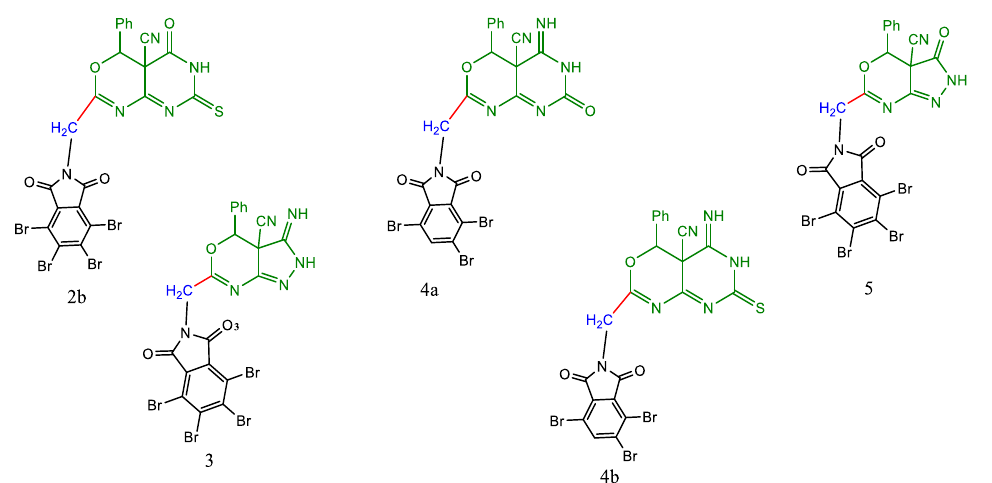
Figure 2. The synthesized compounds 2a , 3 , 4a , 4b , and 5 .